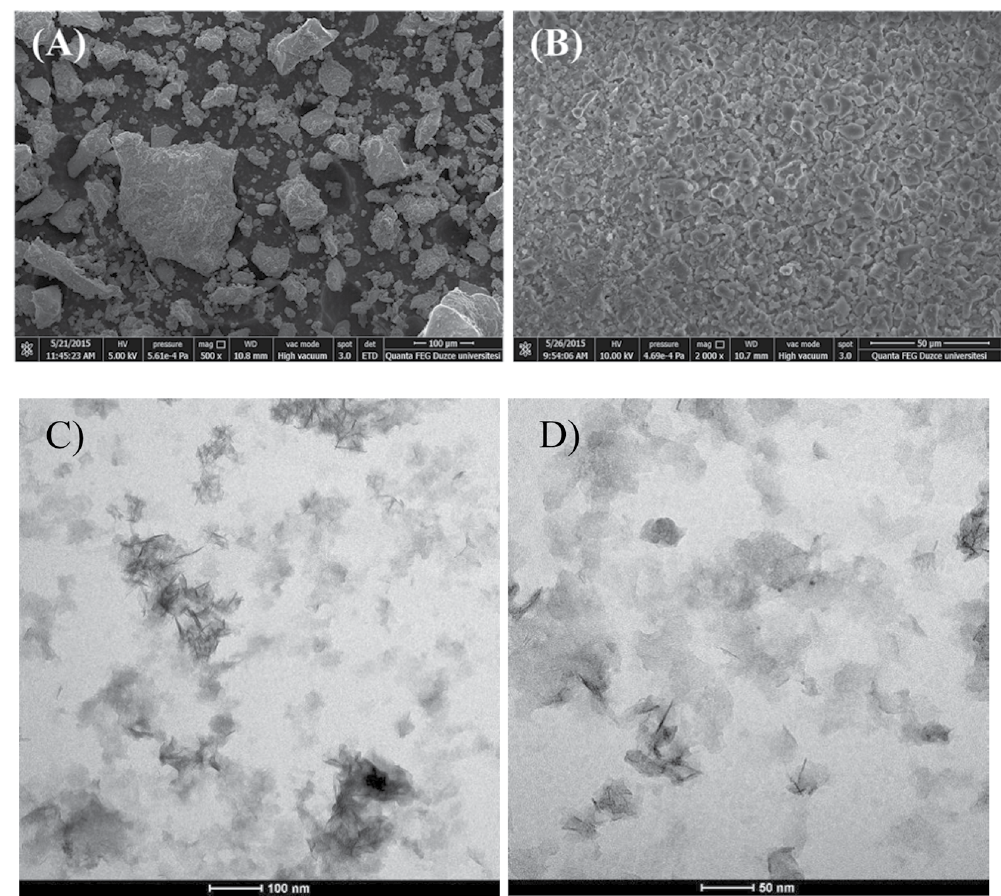
Figure 3. SEM images of Aluminum oxy-hydroxide-supported palladium nanoparticles ( A ) before the reaction; ( B ) after reusing five times. TEM images of Pd/AlO(OH) ( C ) 100 nm scale ( D ) 50 nm